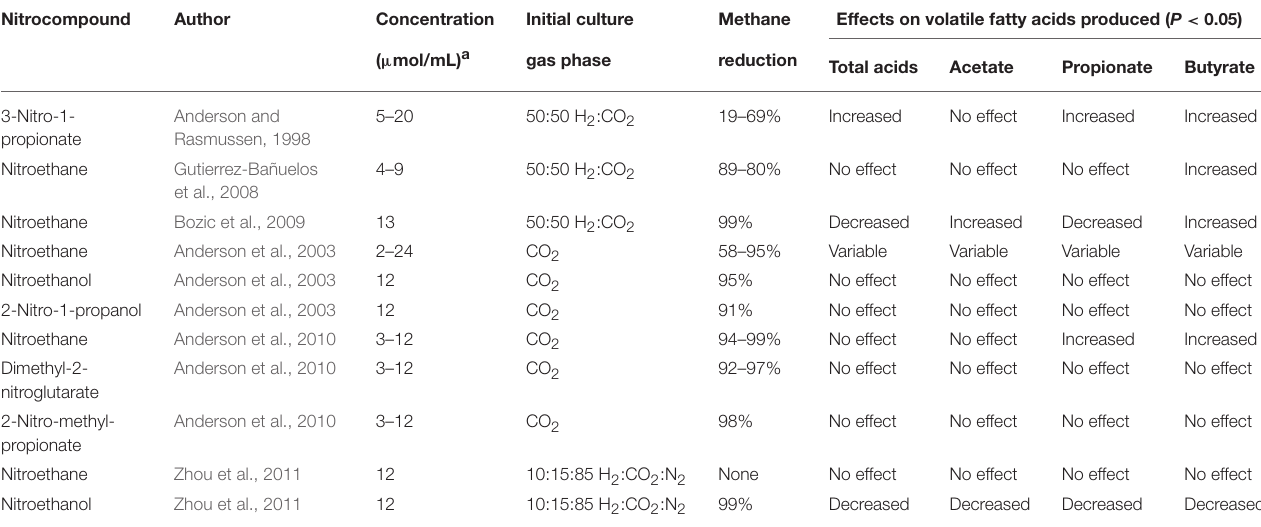
TABLE 5 | Effects of nitrocompound supplementation on methane and volatile fatty acid production during in vitro rumen incubations.